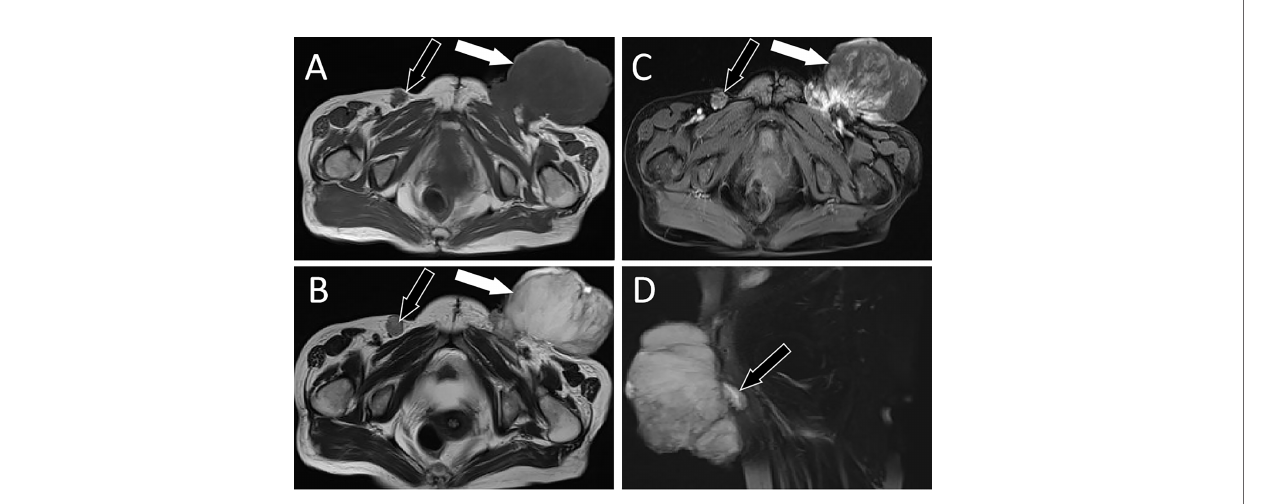
FIGURE 1 | MRI examination; (A) Axial T1WI shows hypointense signal of left groin mass (white arrow) and right inguinal lymph nodes (black arrow). (B) Axial T2WI imaging demonstrates slightly high signal intensity in the left groin area (white arrow) and low signal intensity in the right inguinal lymph nodes (black arrow). (C) Contrast- enhanced T1WI with fat suppression: the left groin mass showed uneven enhancement (white arrow), while the right inguinal lymph nodes showed marginal enhancement (black arrow). (D) Sagittal contrast-enhanced T1WI clearly shows the “ tail fascial sign ” (black arrow). T1WI, T1-weighted images; T2WI, T2-weighted